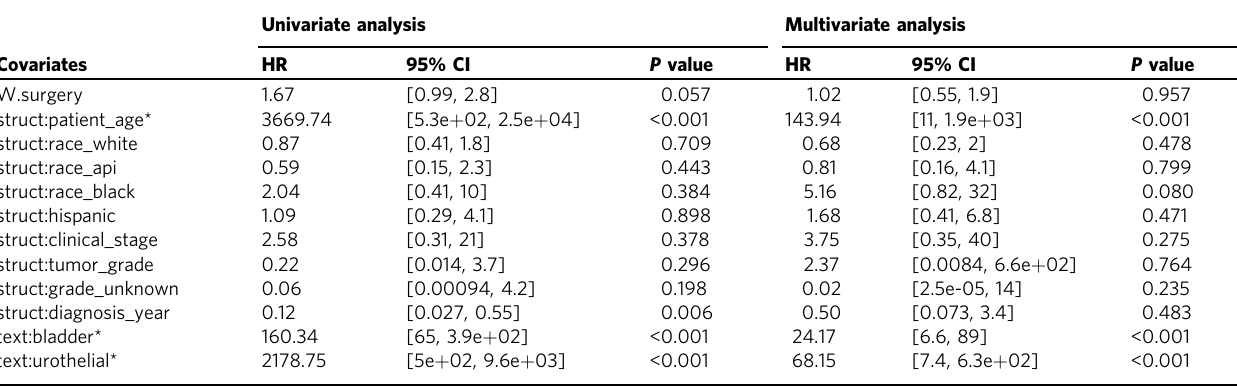
Table 4 Univariate and multivariate covariate-speci fi c HR for surgery vs. active monitoring for prostate cancer. Univariate analysis Multivariate analysis Covariates